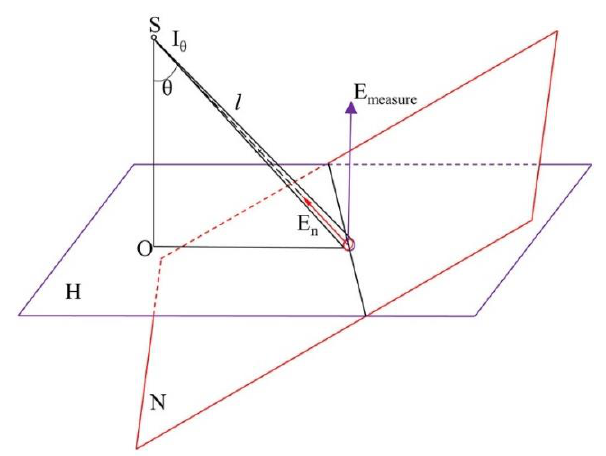
Figure 7. Conversion diagram of vertical illuminance of the tested driver’s eye and the pointing plane illuminance.